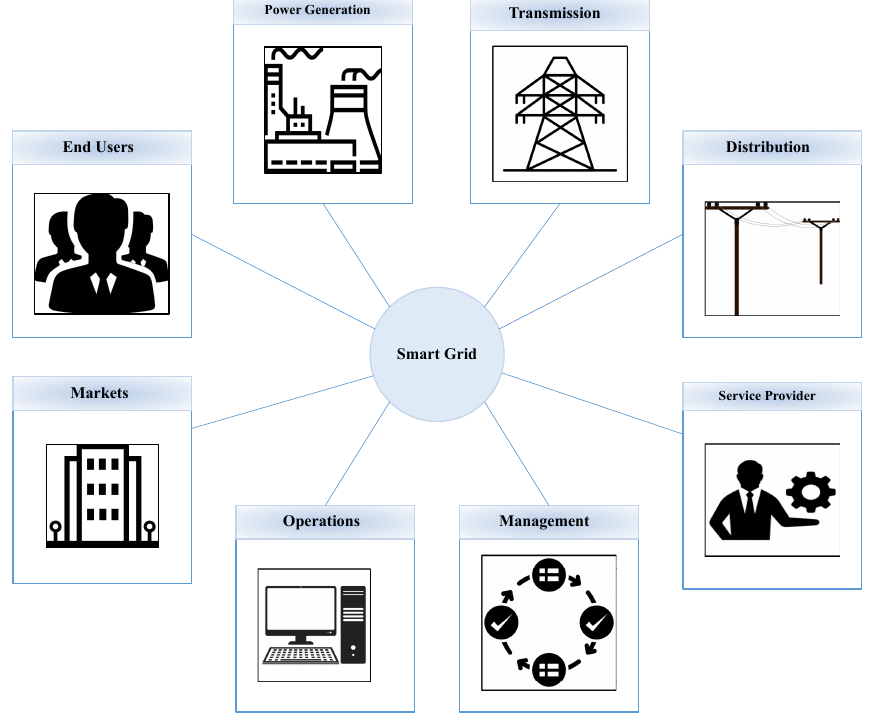
Figure 1. Smart grid